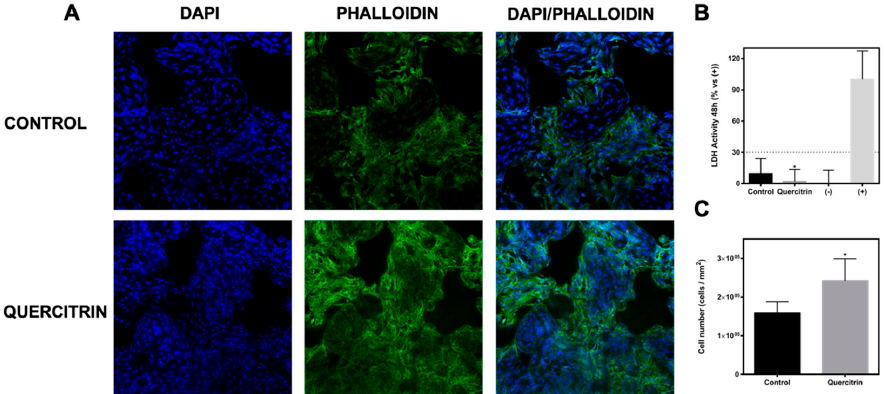
Figure 4. Biocompatibility of the porous implants. A) Confocal micrographs of MC3T3-E1 cells cultured for 48 h on 3D implants. Cells were stained with Phalloidin-FITC (stains actin fibers) and DAPI (stains